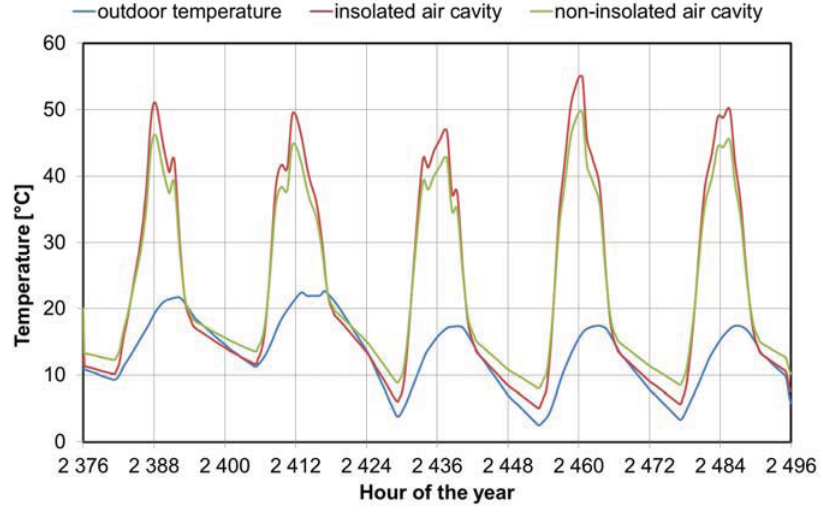
Figure 4: Air collector with the light-weight solar absorber